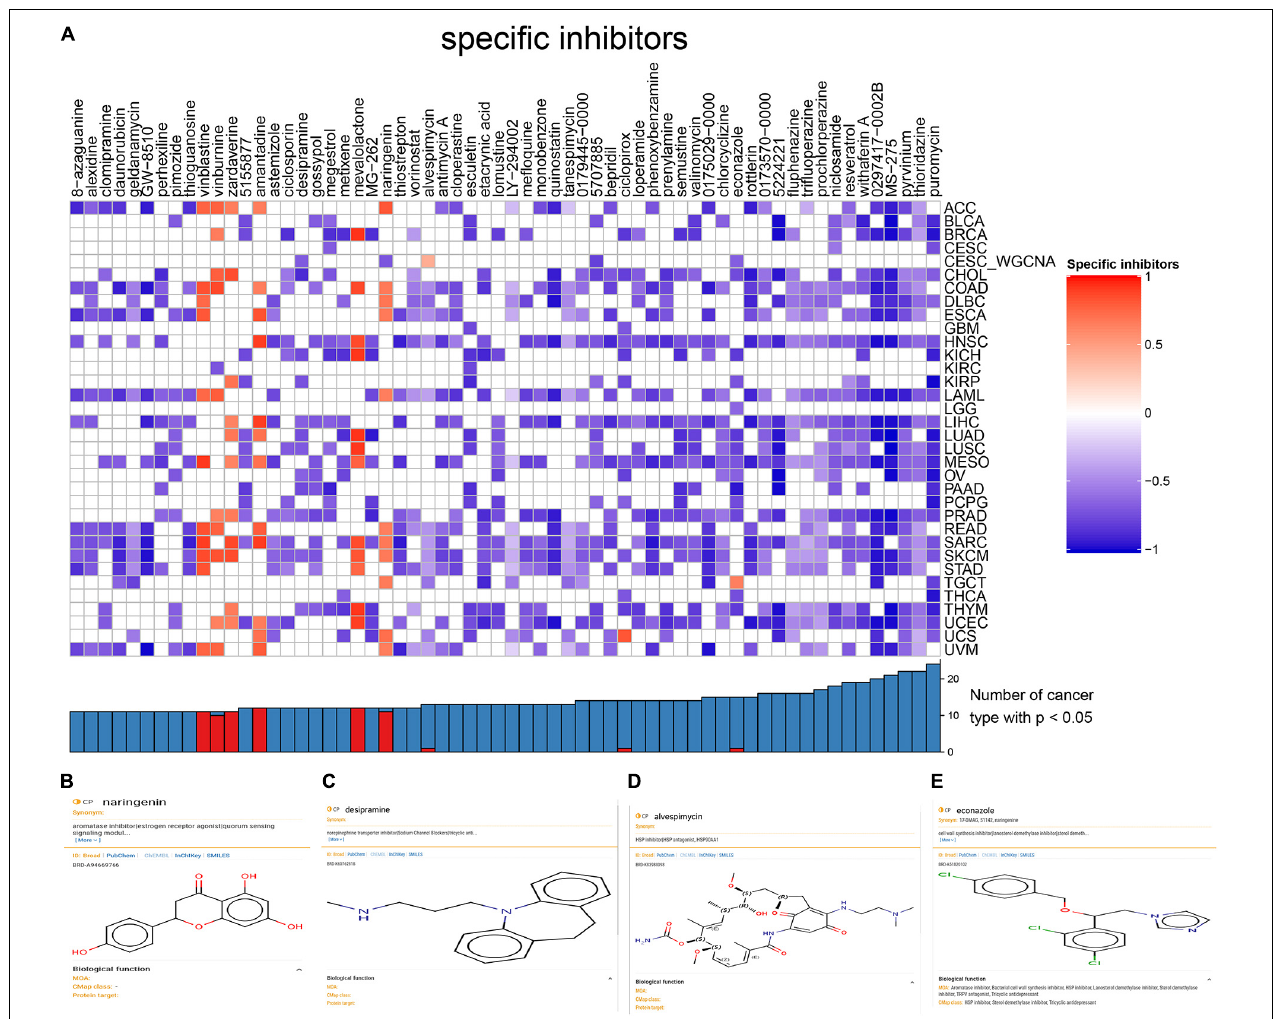
FIGURE 8 | Heat map for small-molecule compounds from the CMap which might be capable of inhibiting CESC via suppressing cancer stemness (A) . Structural formulas and biological functions of naringenin (B) , desipramine (C) , alvespimycin (D) , and econazole (E)